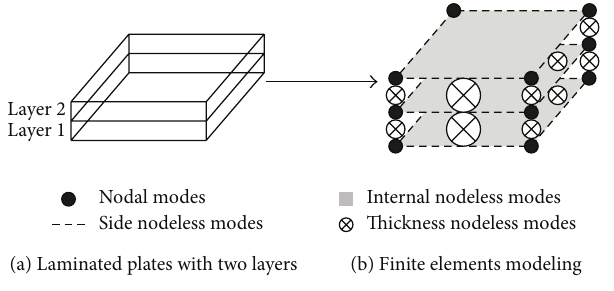
Figure 1: Modeling scheme of laminate plates with two layers using 𝑝 -convergent layerwise